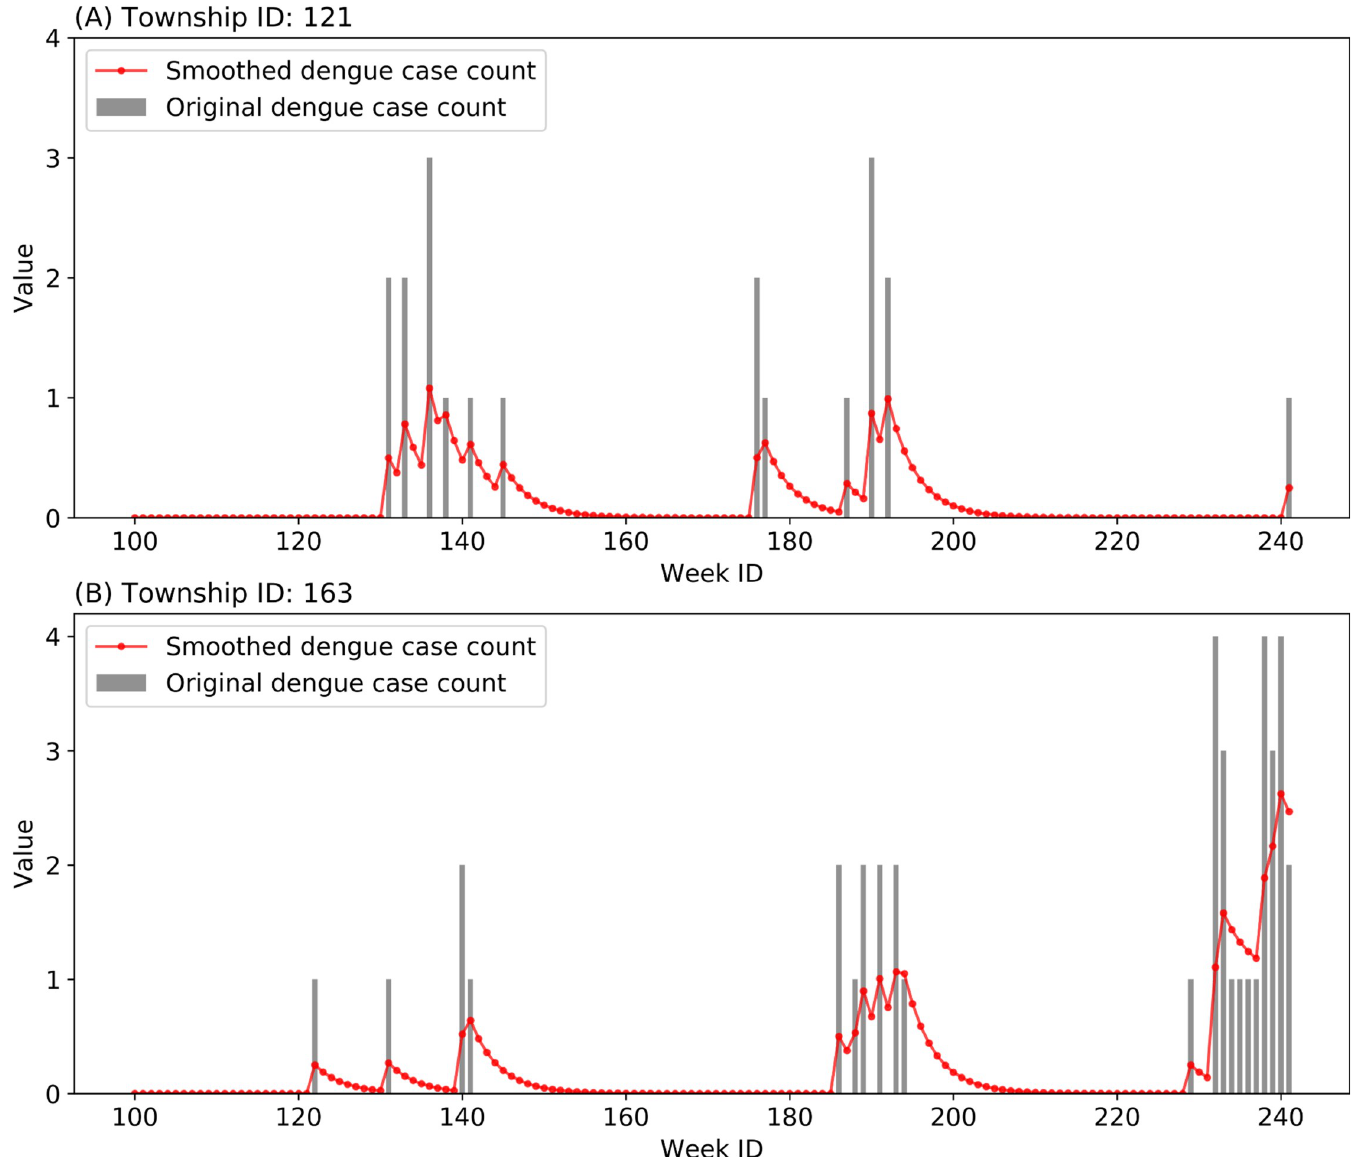
Fig 7. Exponential smoothing ( α s = 0.25) applied to the time series of weekly dengue case count of two townships.